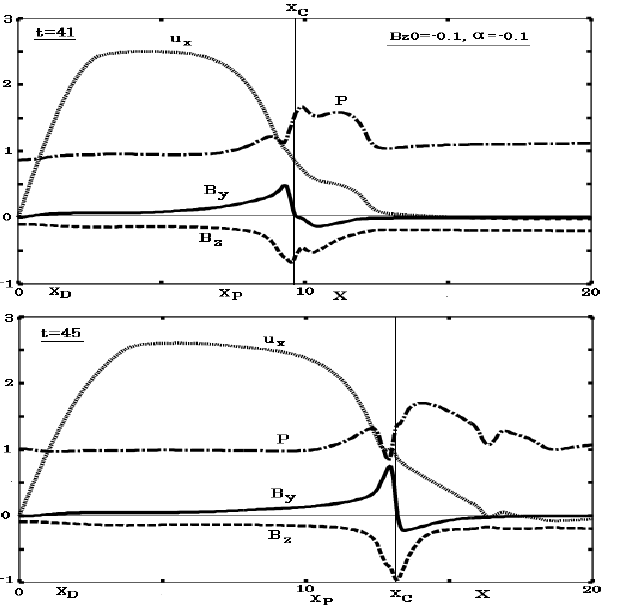
Fig. 6. Profiles of magnetic field components B y and B z , plasma pressure P , and the outflow velocity u x along the x-axis at times Figure 6: Proflles of magnetic fleld components B t = 41 and 45 for the case of B z 0 = − 0 . 1 and α = − 0 . 1, where the plasma pressure P , and the out(cid:176)ow velocity u x along the x axis diffusion region boundary X D , the plasmoid backward end X P and at times t = 41 and 45 for the case of B z 0 = the plasmoid center X C are indicated. 0 : 1, where the difiusion region boundary X D , the plasmoid ¡ backward end X P and the plasmoid center X C are indicated.